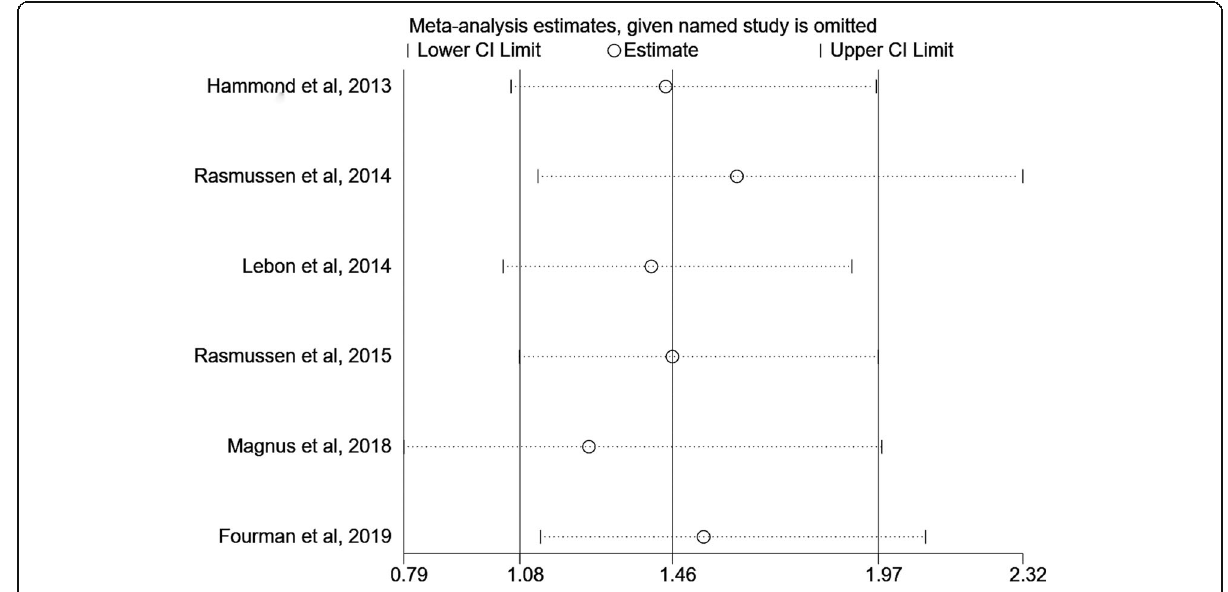
Fig. 13 Sensitivity analysis for revision rate in all included